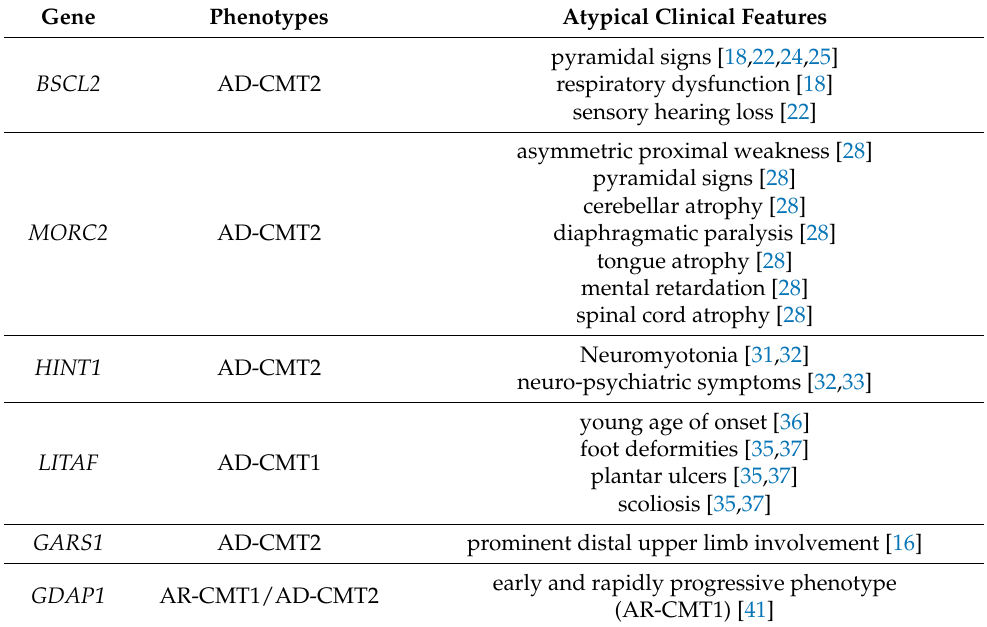
Table 1. Usual phenotypes and atypical features of the BSCL2, MORC2, HINT1, LITAF, GARS1 , and GDAP1